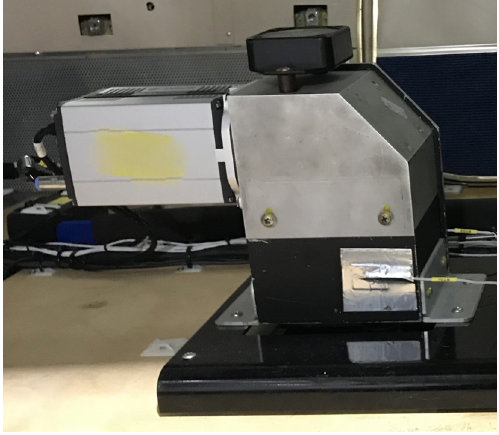
Figure 1. HSI2 installed on the NASA Twin Otter aircraft.